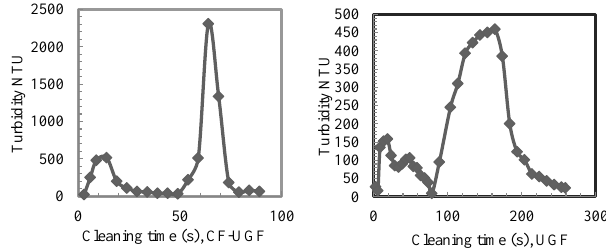
Figure 9. Behaviour of turbidity on a deep clean-up of CF-UGF and UGF 2